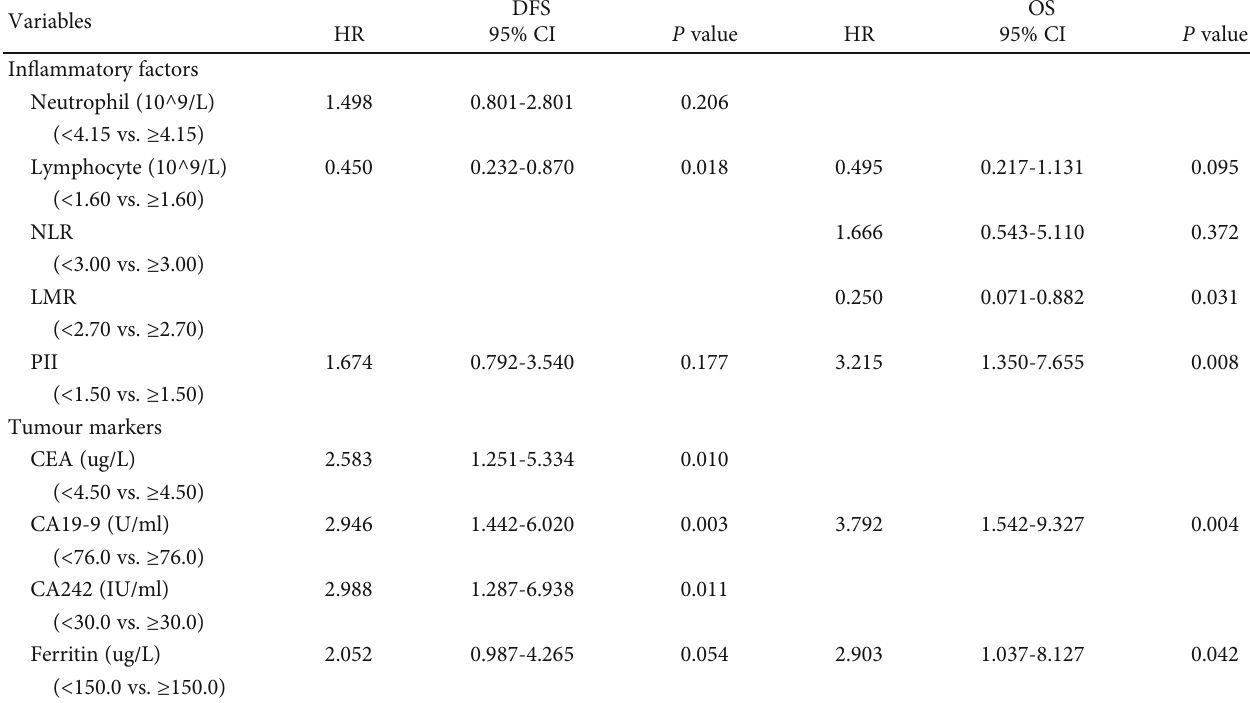
Table 4: Multivariate analysis of prognostic factors for small-duct type ICC in the training